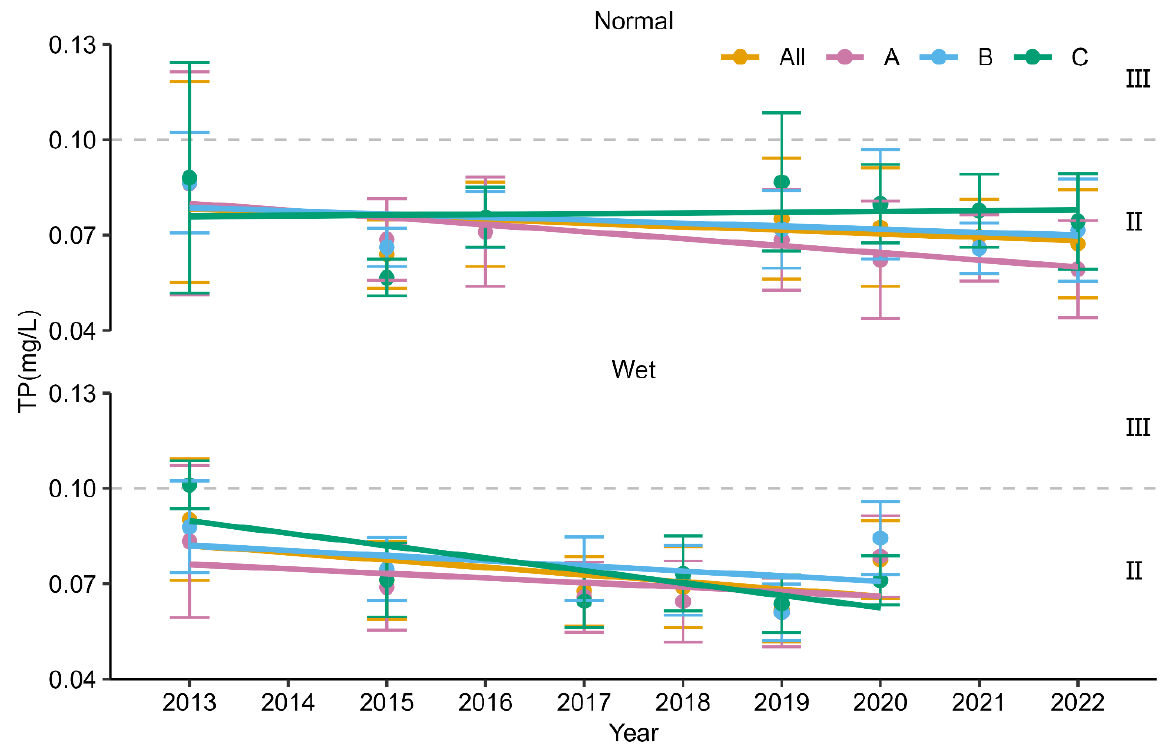
Figure 6. Time series of mean Landsat 8-monitored TP of the NRD for the whole region (All) and three subregions (A, B, and C) in dry, normal, and wet seasons from 2013 to 2022. Ⅱ and Ⅲ are the quality standards for surface water from low to high.